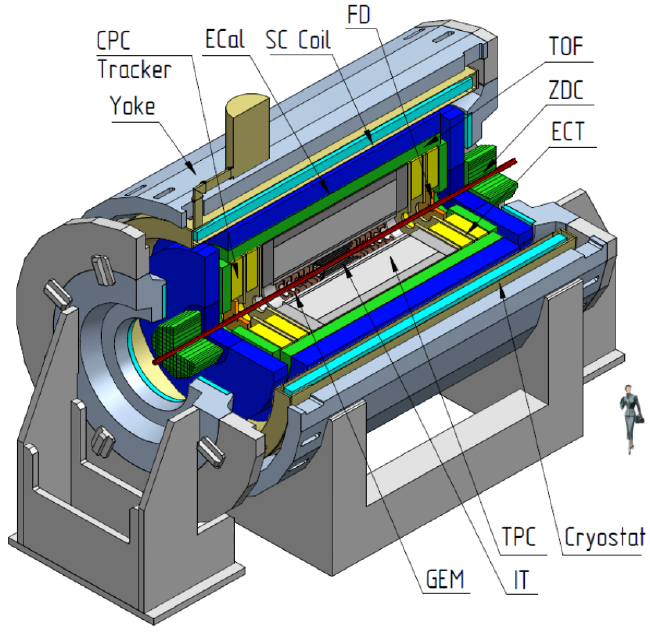
Figure 13. Layout of the MPD experiment at NICA (see text) [48].